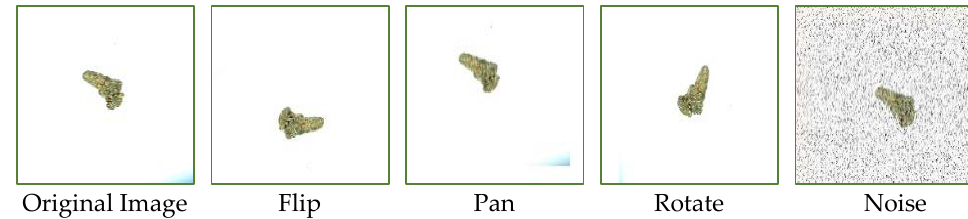
Figure 3. Schematic diagram of image enhancement in the